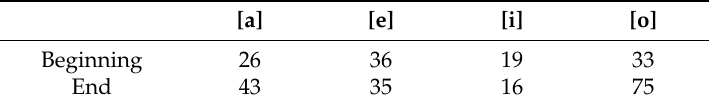
Table A9. Token counts for vowel formant measurements used to assess changes in individual vowel production by Informant C in Section 4.2.3.